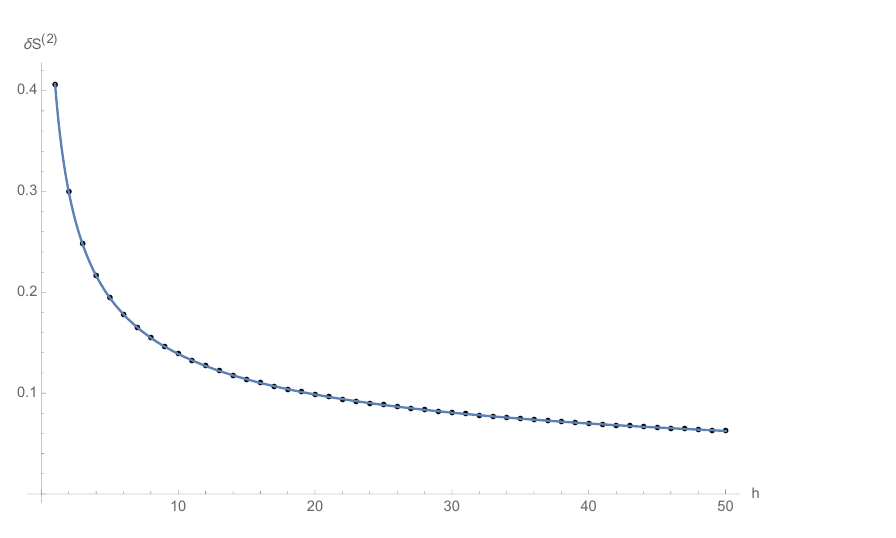
Figure 5: The black dots represent the absolute value of the coefficient of θ 8 h coming from the second order change to the entanglement entropy. The blue line represents the absolute value of the θ 8 h coefficient as calculated from the CFT and exhibits a perfect